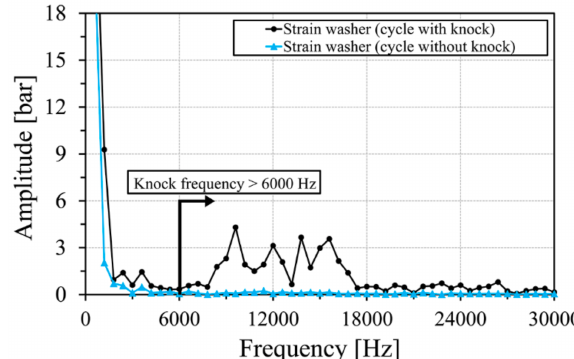
Figure 22. FFT spectrum of the in-cylinder pressure between − 10 CA deg and +45 CA deg derived by the strain washer in case of knock and without knock at 5000 rpm and full